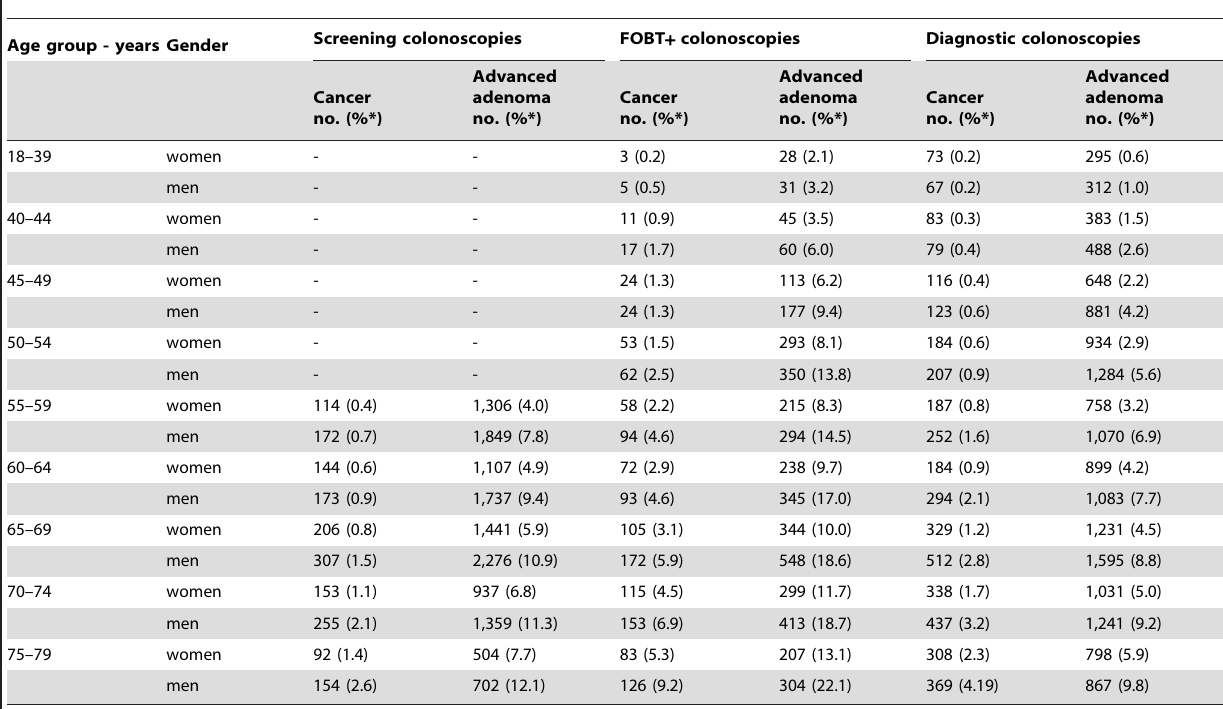
Table 2. Findings on 625,918